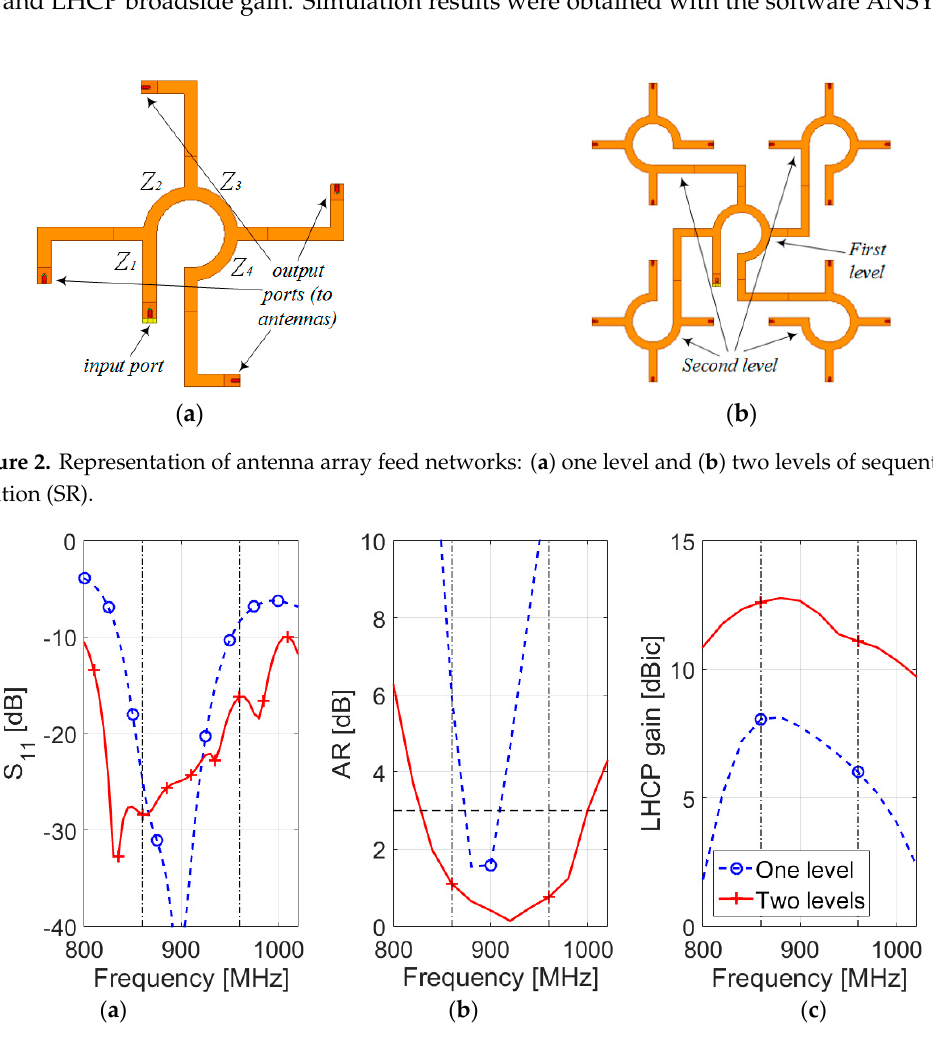
Figure 1. Antenna geometry: ( a ) three-dimensional view, ( b ) detail of lateral view for one antenna element, and ( c ) top view.